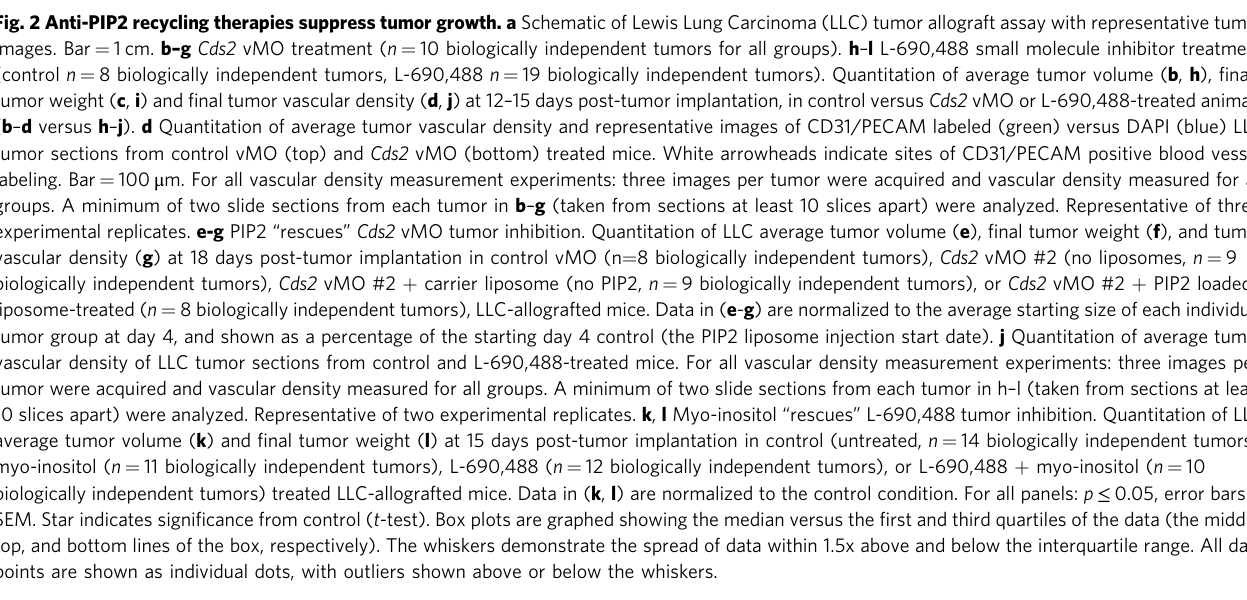
Fig. 10B – D) allografted mice treated with either of the two Cds2 vMOs show decreased tumor volume and decreased fi nal tumor weight compared to control vMO-injected mice. To determine if Cds2 vMO treatments have direct effects on tumor cell proliferation, we exposed isolated B16-F10 or LLC cells in vitro to the estimated comparable doses of Cds2 vMO that they would encounter in vivo and measured proliferation rates. In vitro exposure of LLC or B16-F10 tumor cells to Cds2 vMO does not